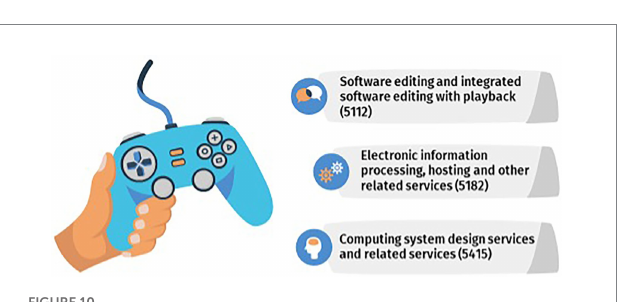
FIGURE 10 Examples of branches of the videogames sector according the NAICS. Own elaboration based on NAICS codes of the Economic